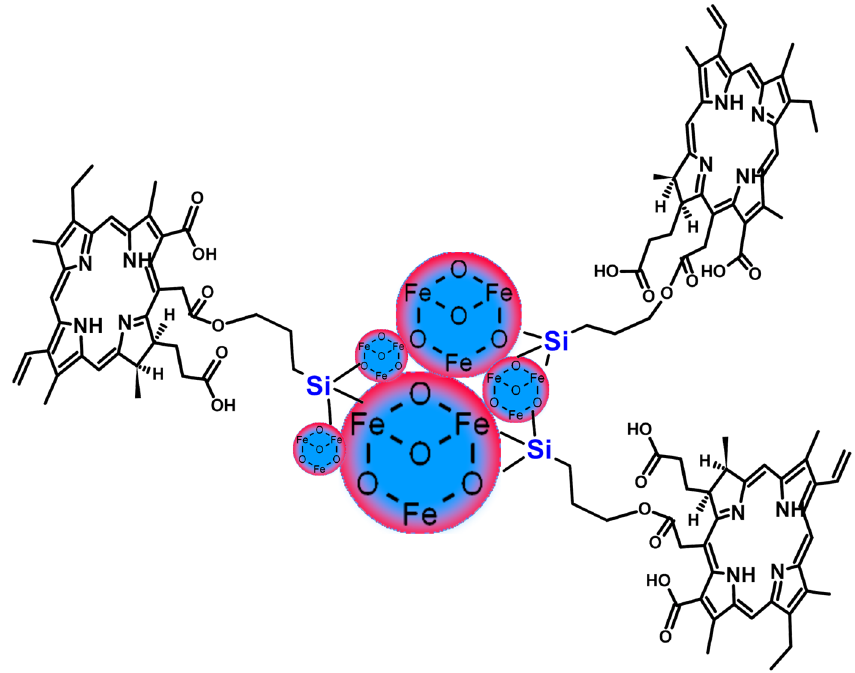
Figure 4. Chemical structure of the Fe 3 O 4 nanoparticles that were modified with Ce6 molecules through alkyl chains [17].